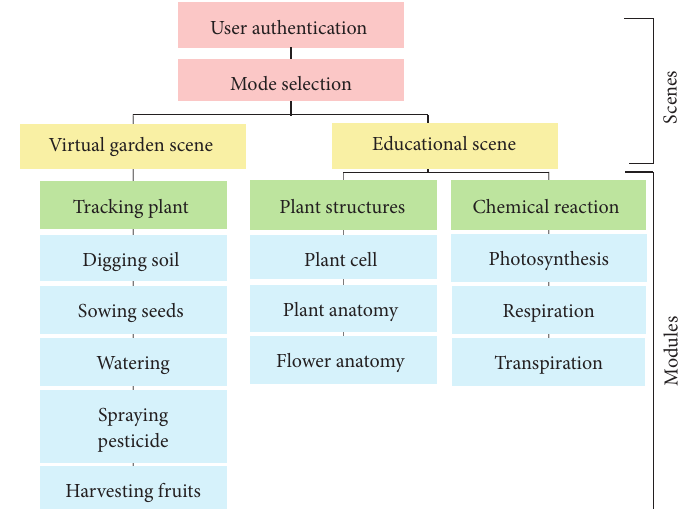
Figure 2: Scenes and modules designed for Little Botany.